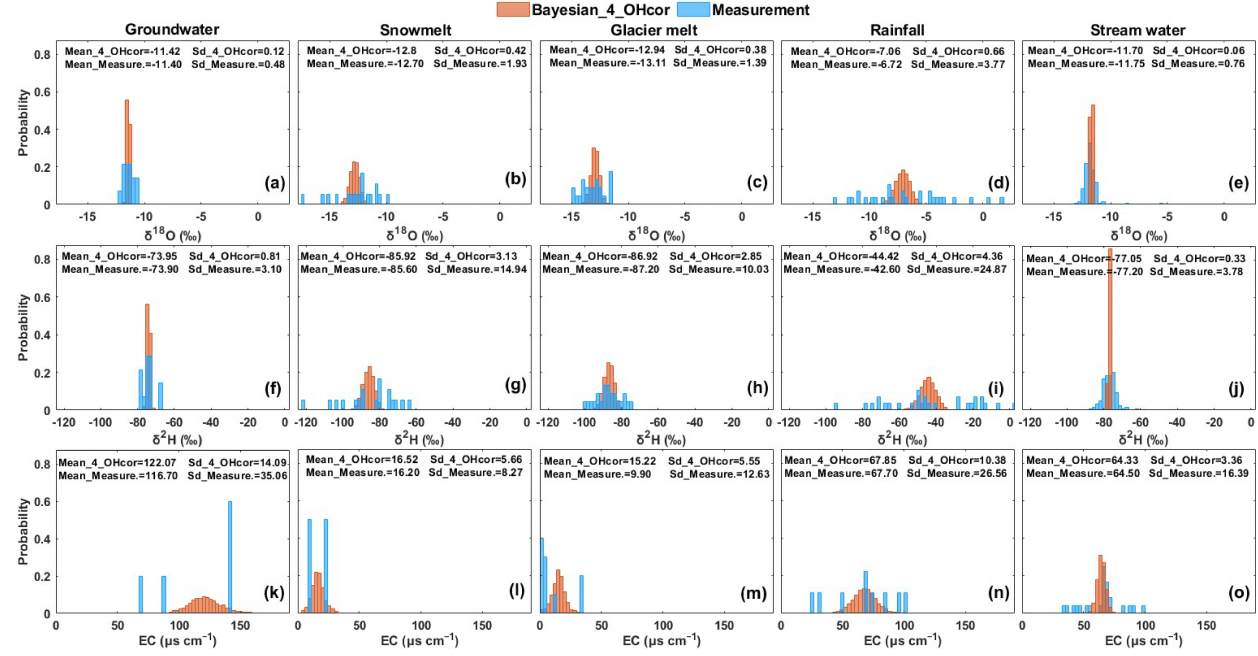
Figure 5. Posterior distributions of tracer signatures estimated by the Bayesian_4_OHcor in the glacier melt season. Measurement refers to the distributions of tracer signatures from the water samples. (a–e) Distributions of δ 18 O; (f–j) distributions of δ 2 H; and (k–o) distributions of EC.